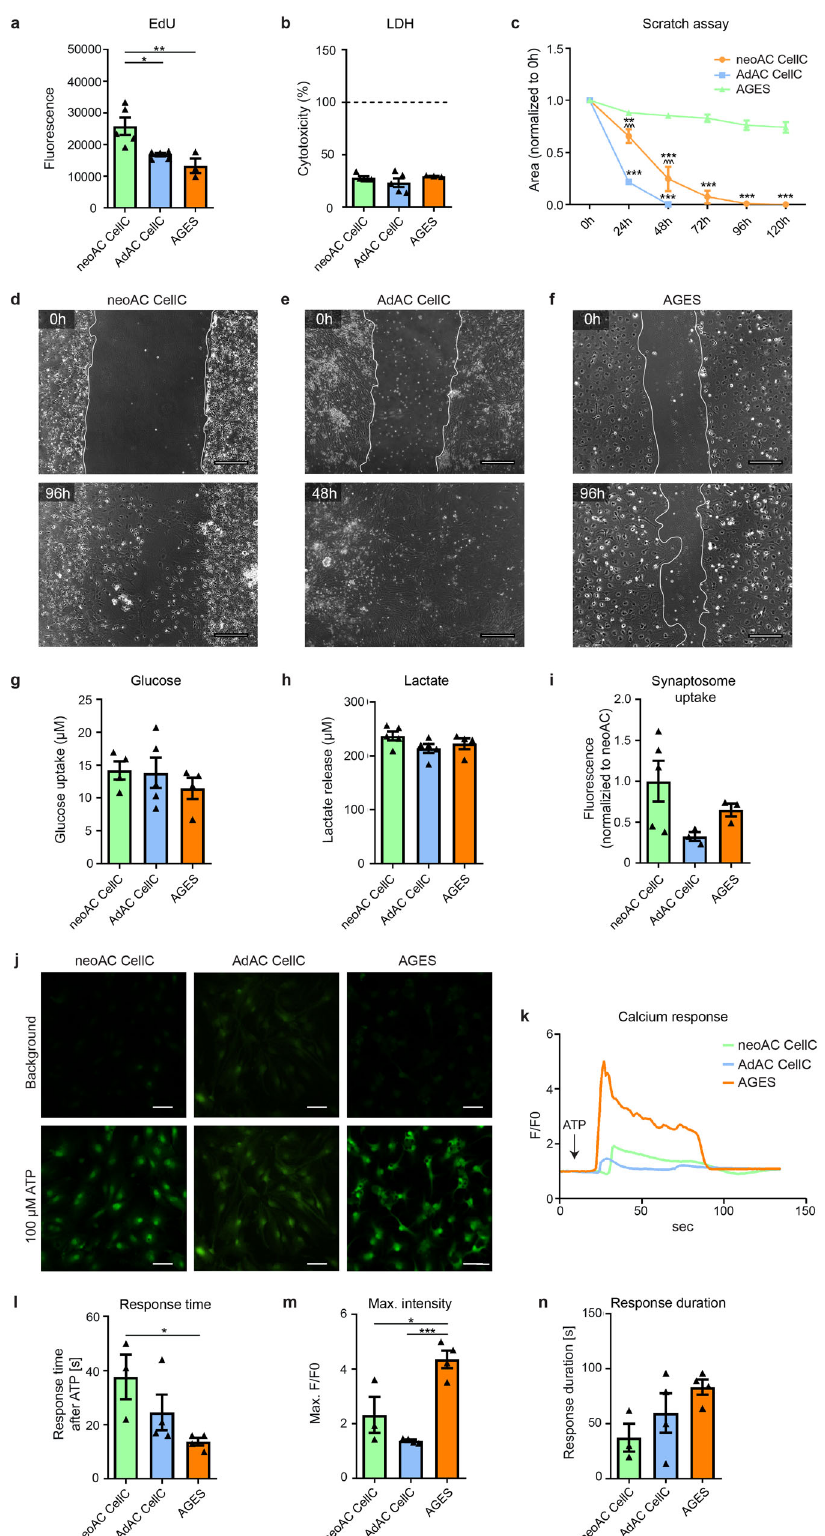
genes is highlighted in red, the fraction of downregulated genes in blue and the non-regulated genes in gray. The intensity of each bar represents the p value allowing for a side-by-side visualization of all comparisons (Fig. 3f, and Supplementary Data 3). Many studies neglect the comparison of stem cell-derived models to either neonatal or adult primary astrocytes and